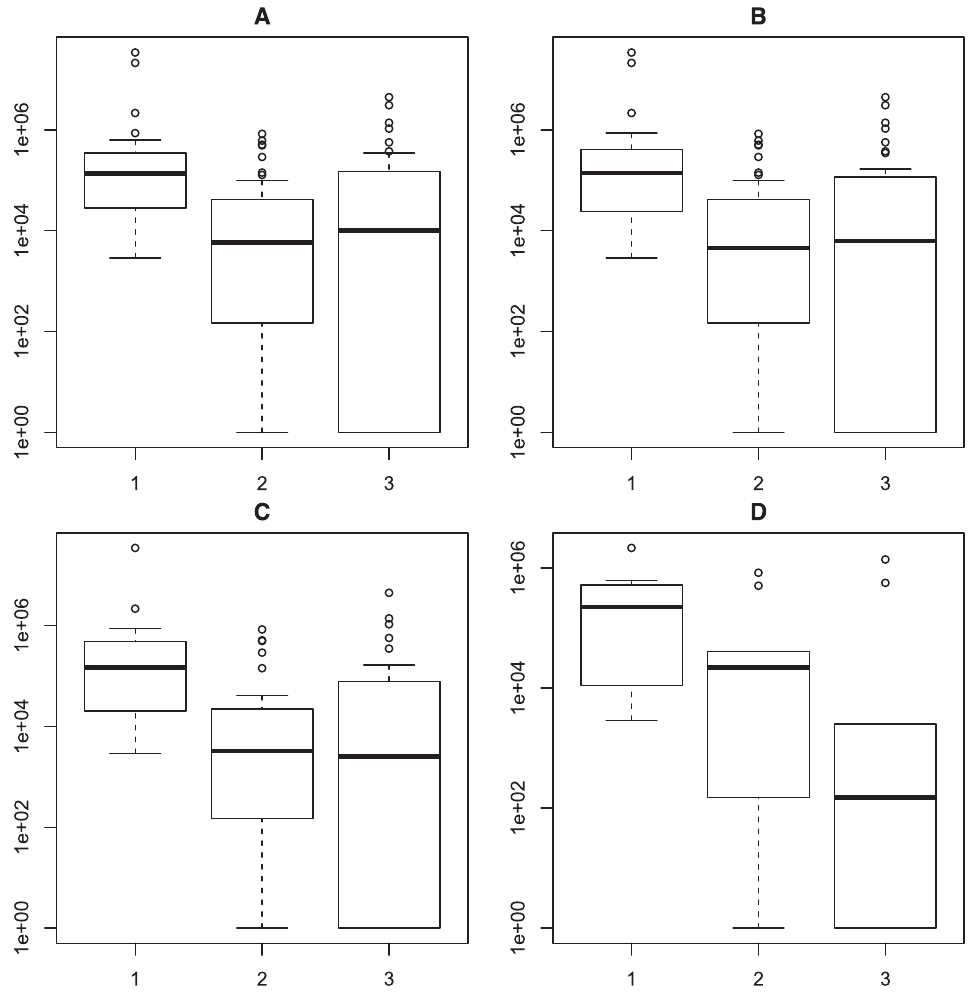
Figure 5. Sequential viral loads in the 50 patients identified during the serological window phase (group G, n=11, excluded). To meet the variability in time lags between last anti- HCV negative to first anti-HCV positive, we compared the median viral load at increasingly shorter lag phases between the first two samples (T). (Panel A. T=182 days, n=47, p , 0.001; panel B. T=152 days, n=43, p , 0.001; panel C. T=122 days, n=35, p , 0.001; panel D. T=92 days, n=11, p=0.123). Analysis by Wilcoxon signed rank test. Figures 1, 2, and 3 on the X-axis refer to samples drawn pre-seroconversion, seroconversion and 1 year follow up, respectively.